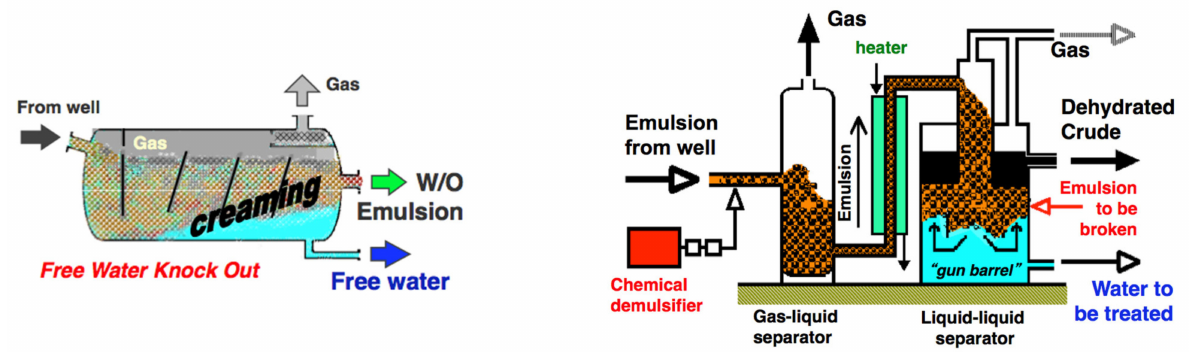
Figure 24. Separation of oil and water phase at the petroleum